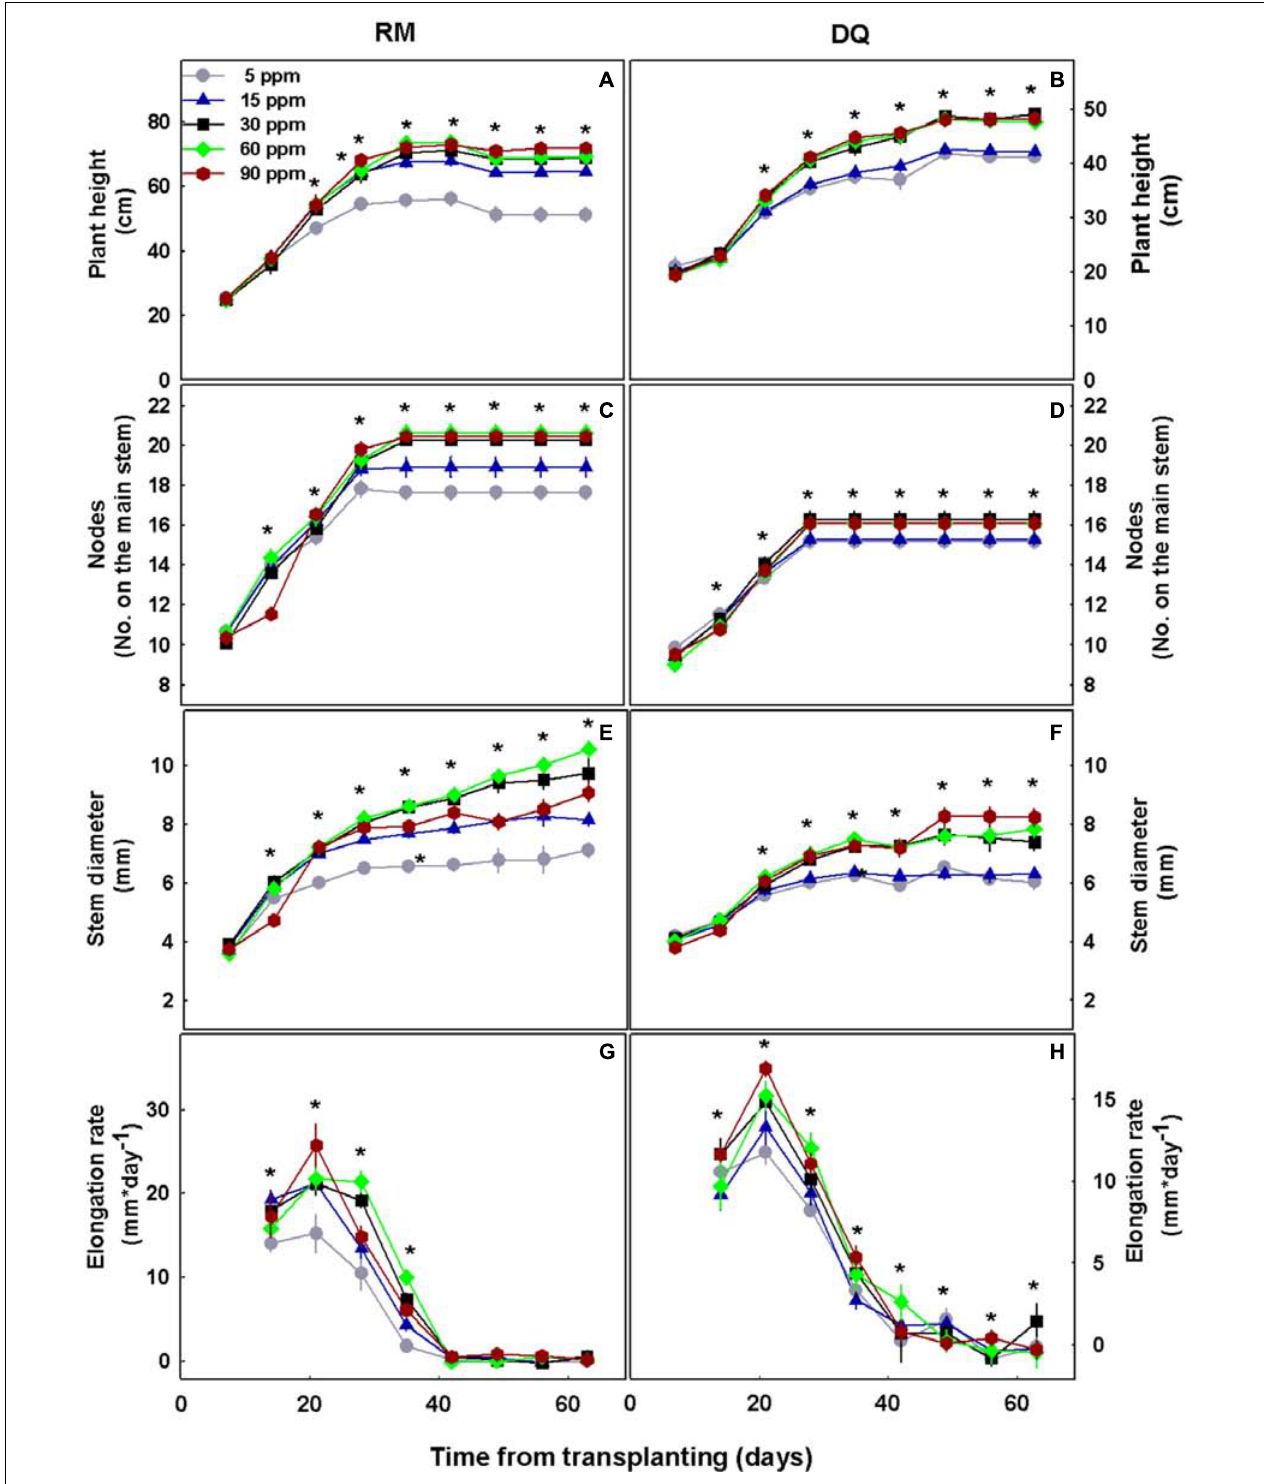
FIGURE 1 | Effect of P concentration on development of two medical cannabis cultivars, RM and DQ, at the flowering phase. Plant height (A,B) , number of nodes on the main stem (C,D) , stem diameter (E,F) , and elongation rate (G,H) . The first measurement represents the time of initiation of the P treatments, and the short photoperiod. Presented data are averages ± SD ( n = 6). An asterisk above the averages represents a significant difference between treatments for a given day by Tukey’s HSD test at α = 0.05.